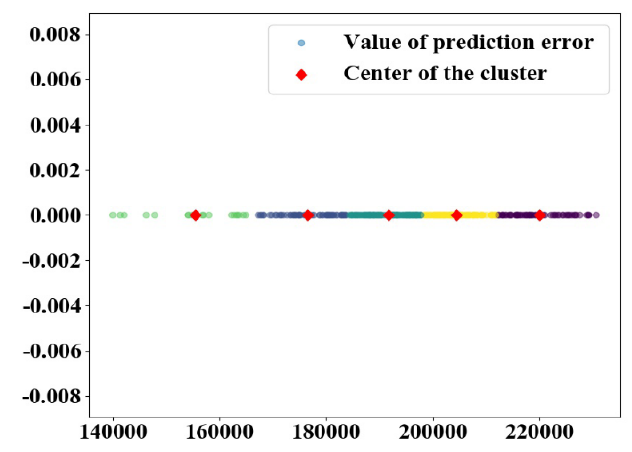
Water 2020 , 12 , x FOR PEER REVIEW Figure 10. Data clustering of monitoring point 1. Figure 10. Data clustering of monitoring point 1.